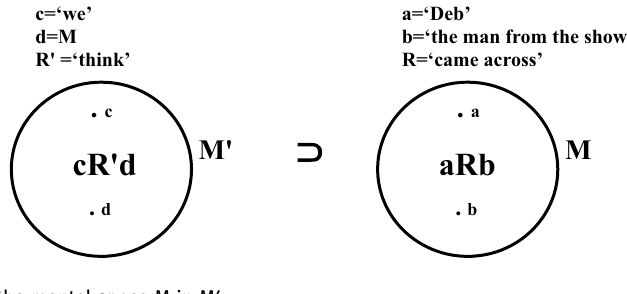
Figure 5: The inclusion of the mental space M in M ′ .